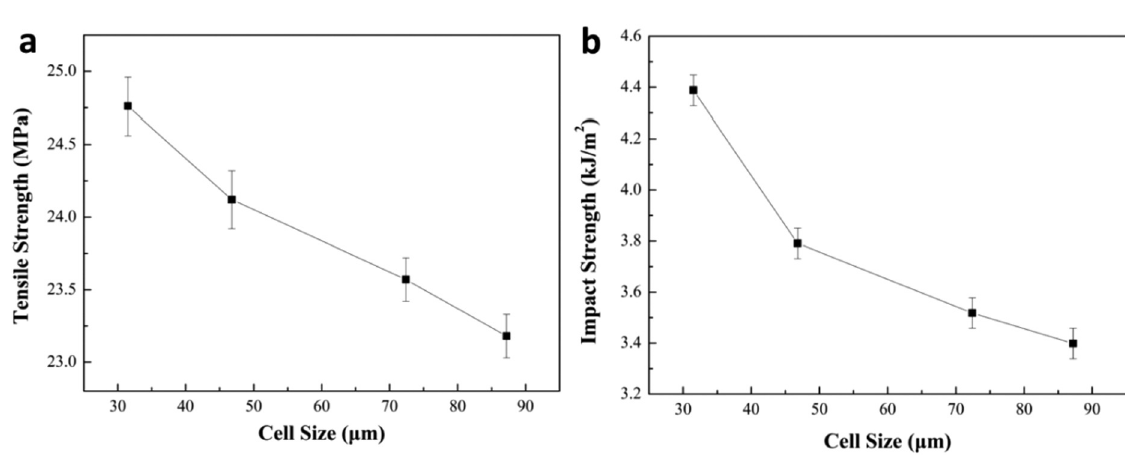
Figure 1: Relationships of the average cell size and ( a ) the tensile and ( b ) impact strengths of the PP foams with the same volume expansion